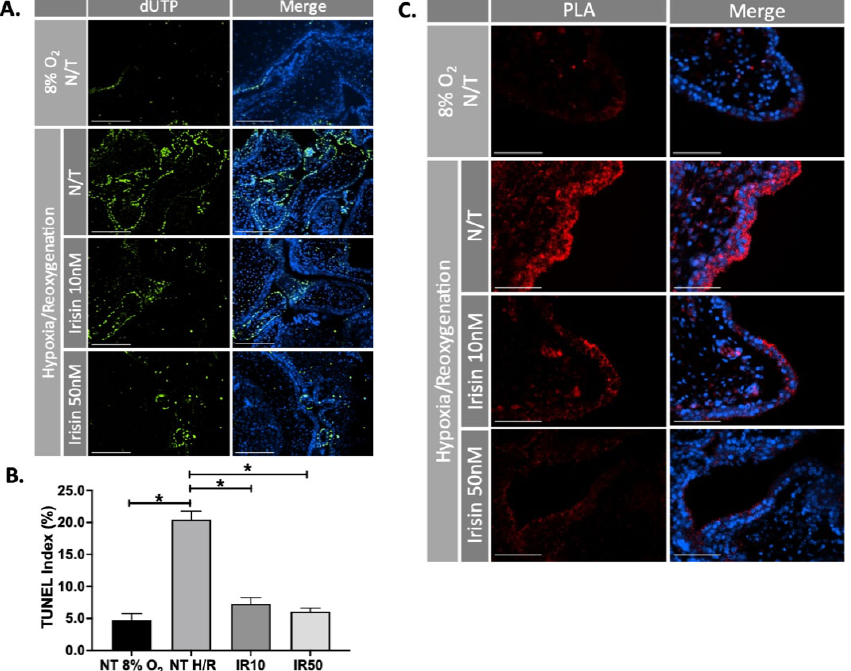
Figure 2. Irisin reduces apoptosis and improves cell survival in the ischemic 1st trimester human placenta. ( A , B ) Irisin significantly reduced the number of apoptotic cells during H/R in the first trimester placenta, as identified by a reduction of green fluorescent molecules in the TUNEL assay (n = 4). ( C ) The interaction between APAF1 and Cytochrome C (the early sign for initiation of apoptosis) indicated by red fluorescent molecules, was significantly diminished when H/R stressed first trimester placental explants were exposed to Irisin. The molecular interaction was studied by immunofluorescence in situ PLA, a novel technique that enables visualization of molecular proximity at single molecule resolution. (Significant changes in TUNEL index were measured by a one ‐ way analysis of variance and subsequent Tukey’s post hoc test to analyze differences between cohorts; * p < 0.05, ** p < 0.01. Scale bar = 100 μ M. Green fluorescent staining indicates DNA strand breaks ( A ); Blue fluorescent staining is for Dapi indicating the cell nucleus ( A , C ); Red fluorescent staining indicates APAF1 and Cytochrome C interaction ( C ). Bar plots are presented as mean ± SEM; N/T, non ‐ treatment; H/R, hypoxia/re ‐ oxygenation; PLA, Proximity Ligation Assay; dUTP, deoxyUridine Tri ‐ Phosphate).